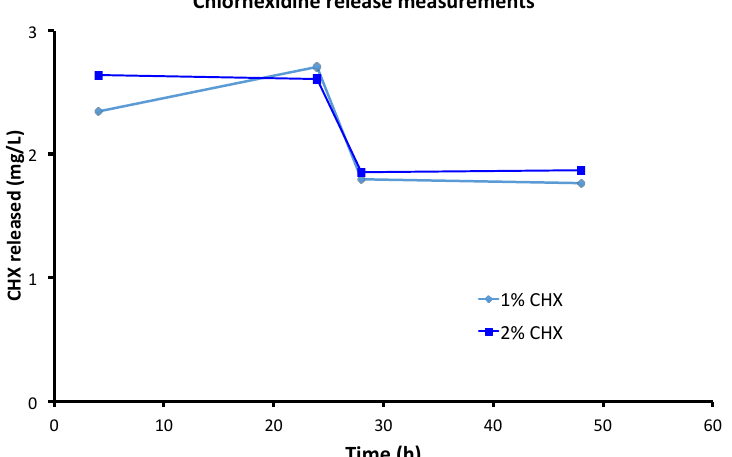
Figure 2. Chlorhexidine release measurements: release of chlorhexidine (CHX) from calcium hydroxide + CHX pastes with 1% (10 × 10 3 mg/L) and 2% (20 × 10 3 mg/L) CHX over 48 h.